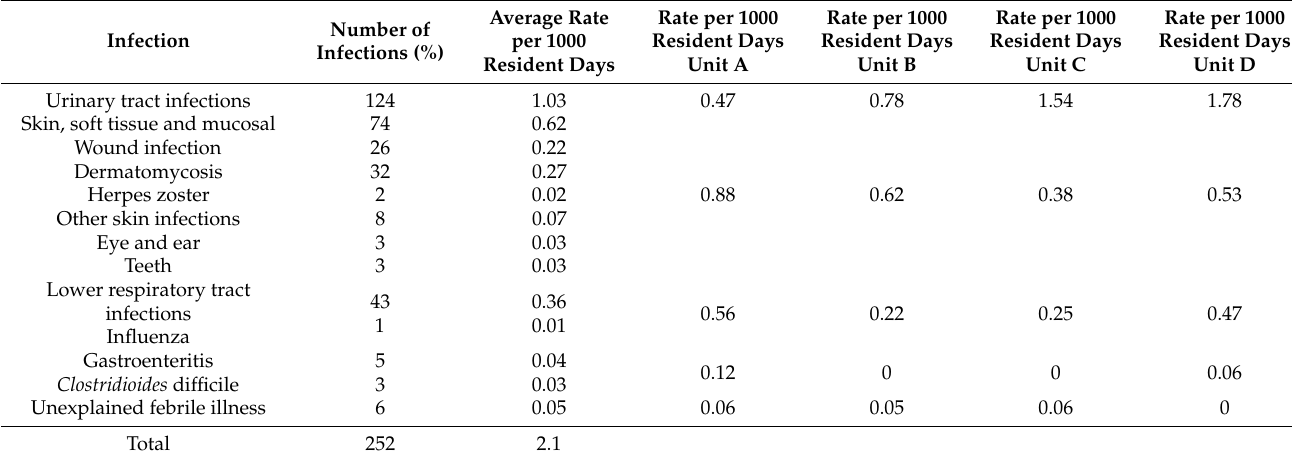
Table 1. Number of healthcare-associated infections and incidence rates during a 12-month surveillance period in four long-term care facilities.